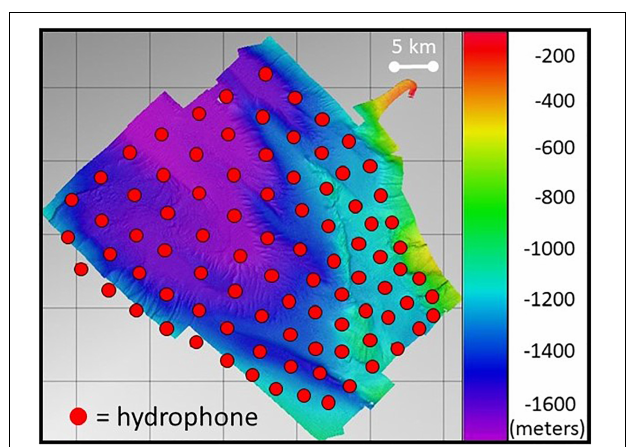
FIGURE 1 | Bathymetry of the SOAR with overlaid 89 hydrophone (red circles) sensors in the array. Depth scale is in meters. Reproduced from Kates Varghese et al. (2020) with the permission of the Acoustical Society of America.